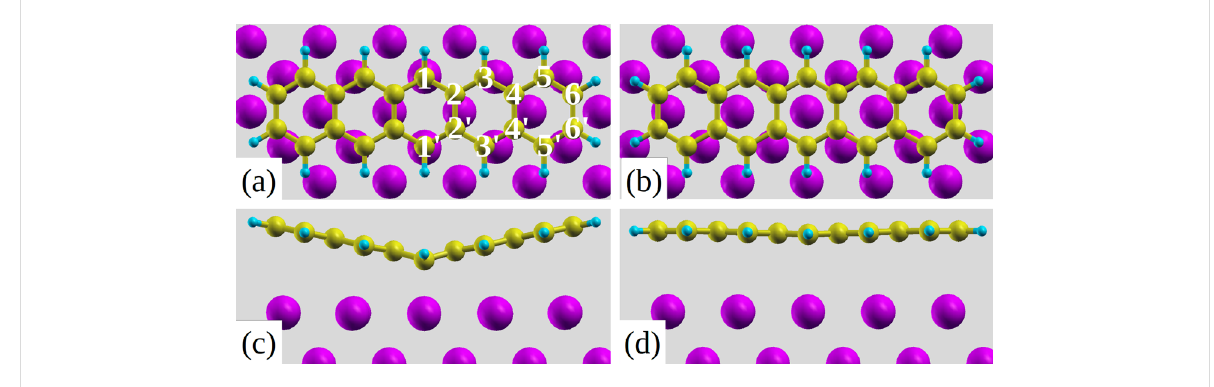
Figure 1: Top views (a), (b) and side views (c), (d) of bridge (B) and top (T) sites, respectively, where (a) also shows the numbering of the C atoms.